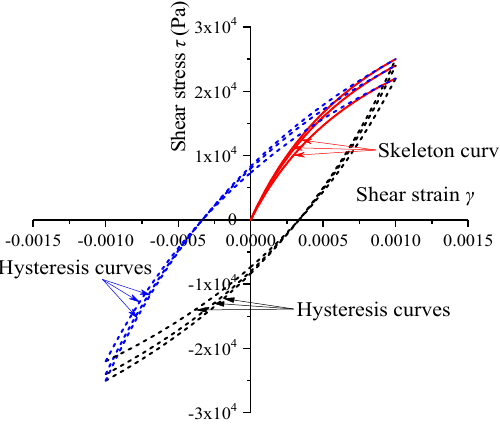
Figure 2. Dynamic shear stress–shear strain curves of the Davidenkov model.